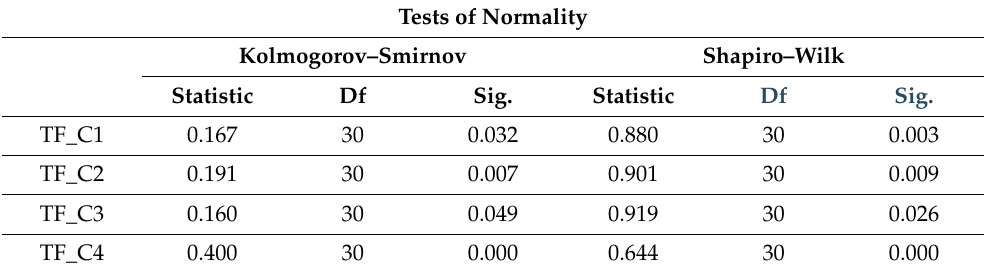
Table 10. Normality test on traffic flow value.